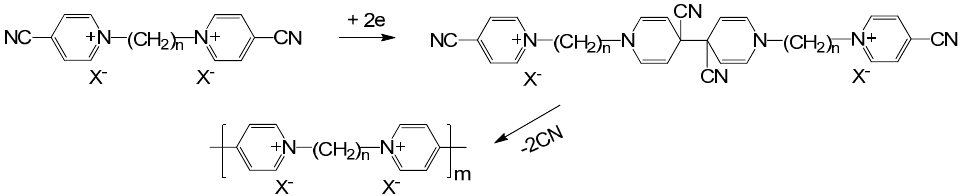
Figure 6. Electropolymerization of bis(4-cyano-1-pyridino)alkanes to polyviologens.